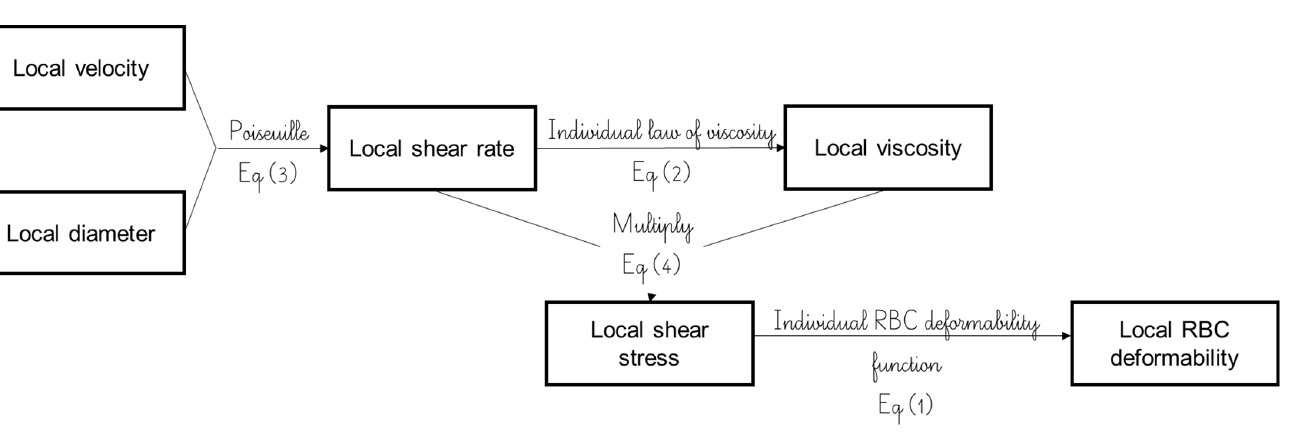
Figure 5. Blood rheological characterization flowchart using individual parameter estimations of each vessel size.